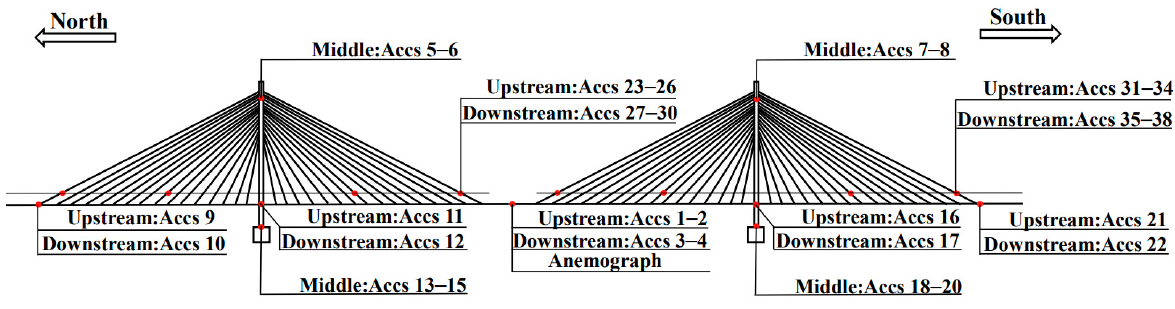
Figure 1. General layout of accelerometers in the cable-stayed bridge.